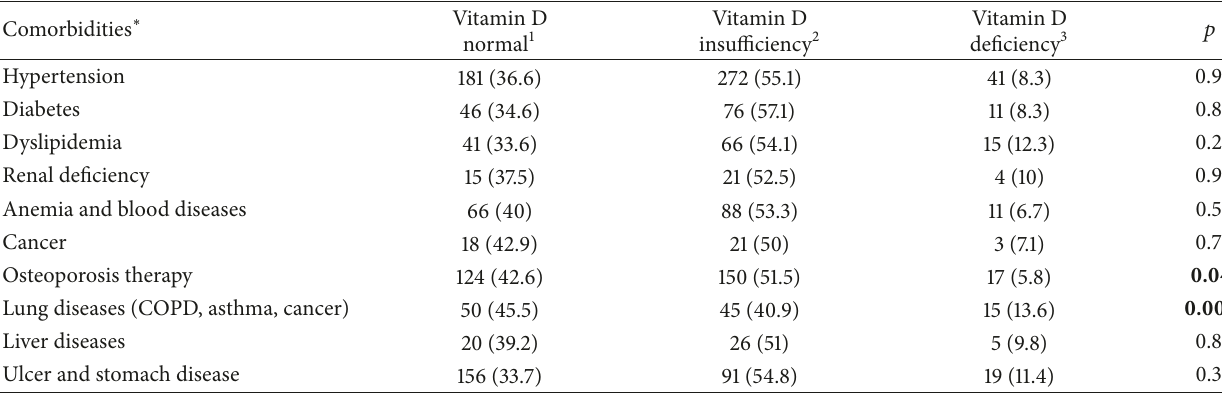
Table 4: Association analysis between comorbidities and vitamin D